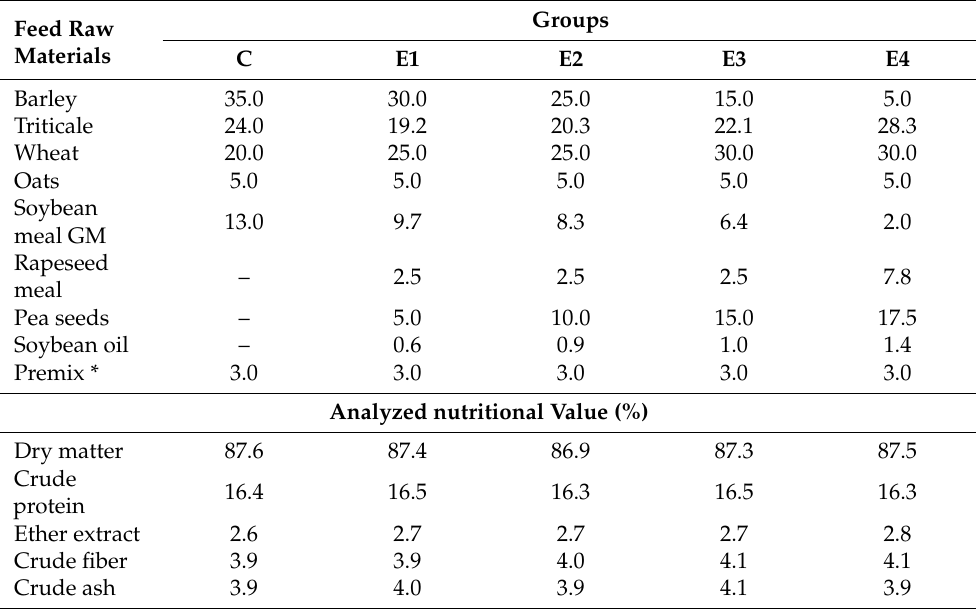
Table 3. Composition of feed mixtures at stage I of fattening